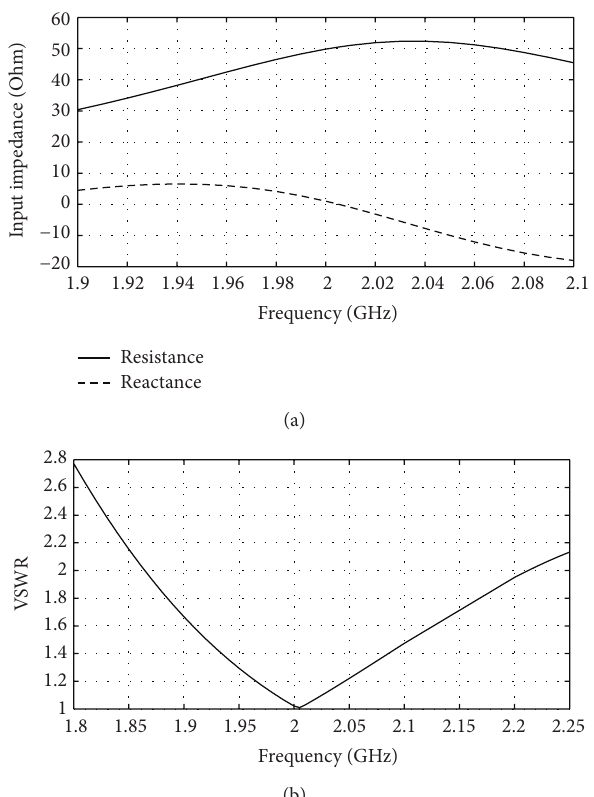
Figure 15: Variation of (a) the input impedance and (b) VSWR of a split coaxial balun feeding a dipole antenna with the frequency for a 50 Ω -source; 𝐷 = 6.72 cm, 𝐿 𝐿 1 out = 3.8 mm, and 𝜃 𝐿 𝑡 = 2.2 𝑊 𝐷